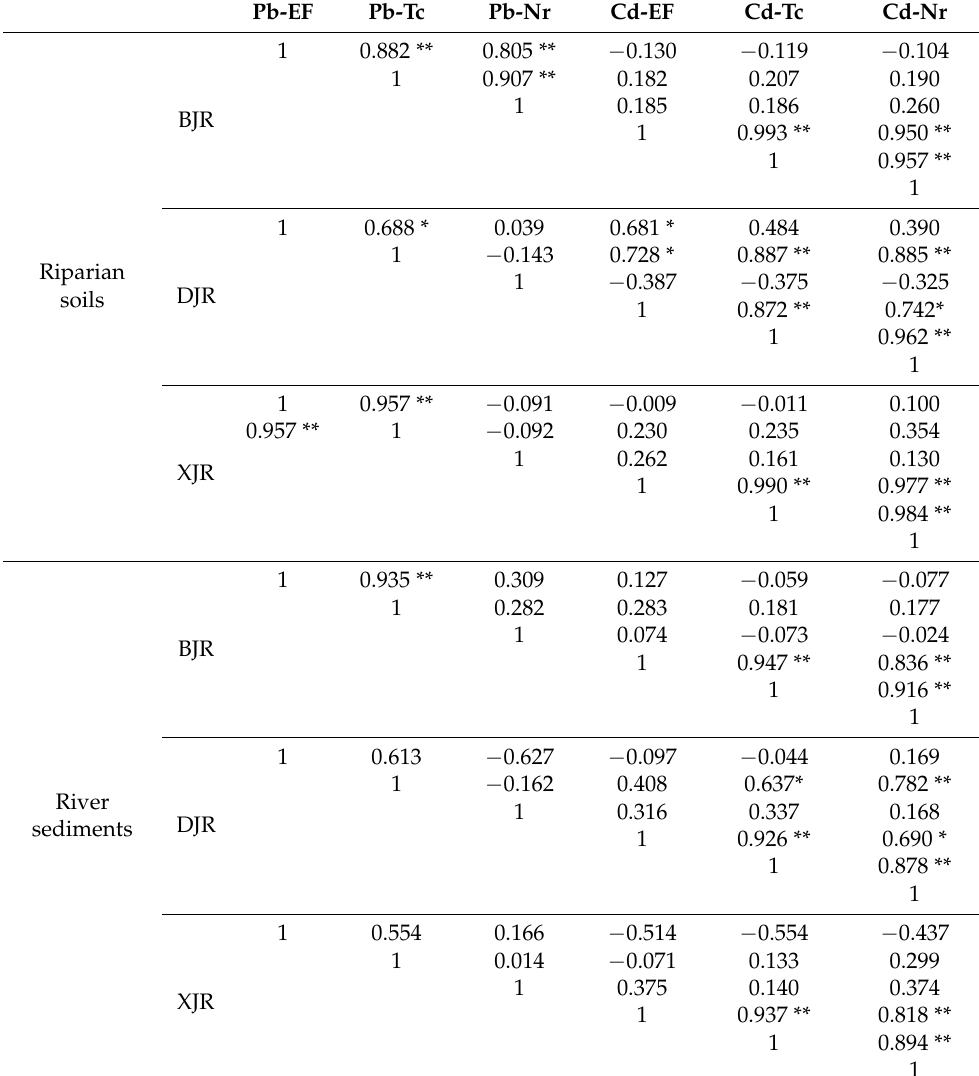
Table 2. Correlation relationship between enrichment factors, total contents, and nonresidual fractions of Pb and Cd in riparian soils and river sediments from three reaches. Pb-EF